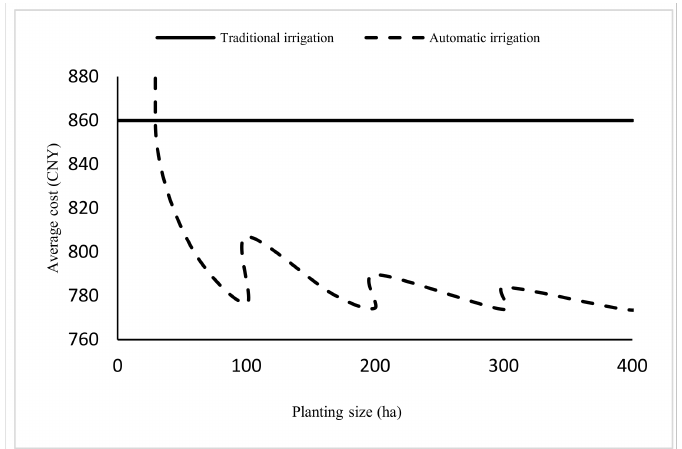
Figure 4. Effect of planting size on the average cost of water and fertilizer